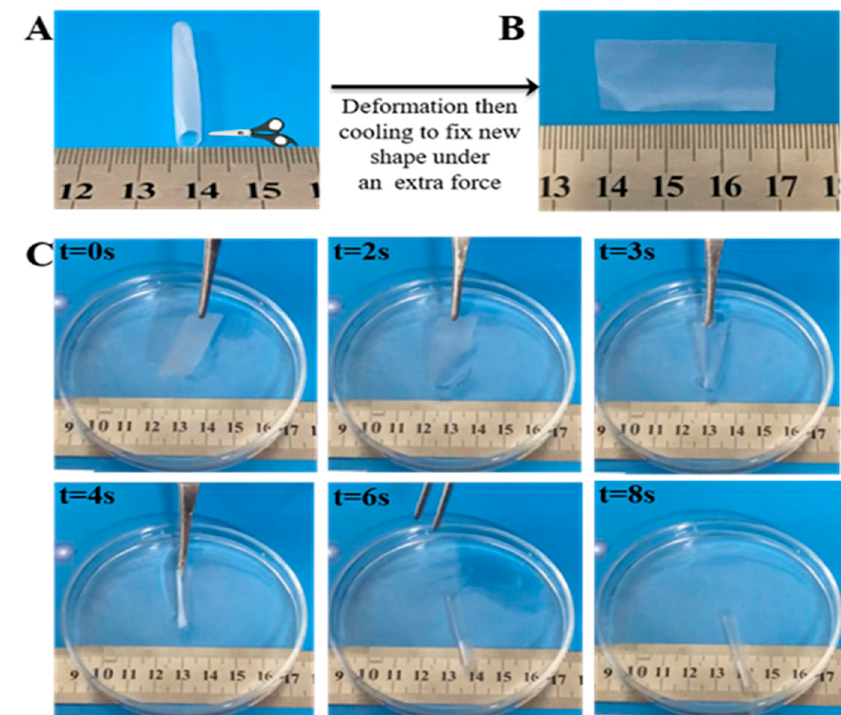
Figure 6. ( A ) Original shape of the PHP tube. ( B ) The tube was cut off and fixed into temporary planar shapes at − 10 ◦ C. ( C ) Time sequence of photographs showing self-folding of PHP films. The film was initially spread without water ( t = 0), and then immersed in PBS ( t = 2–4 s), causing rapid curling. The permanent shapes (at 37 ◦ C in PBS) of the PHP tube in water resulted in instantaneous entangling to its original shape ( t = 6–8 s).